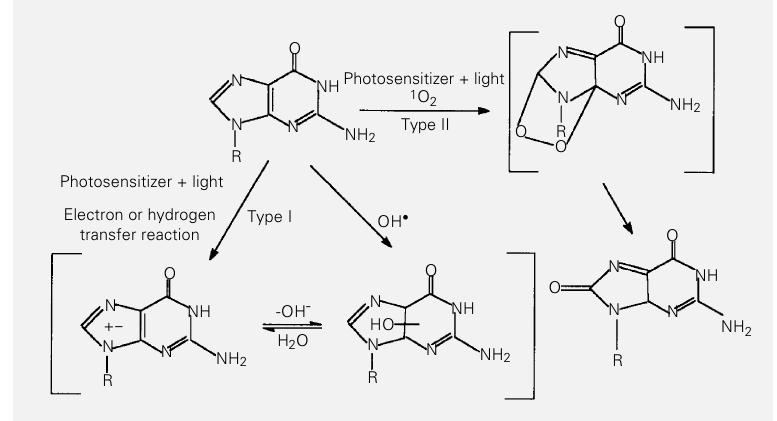
Figure 5 - Guanine radical intermediates from type I and type II